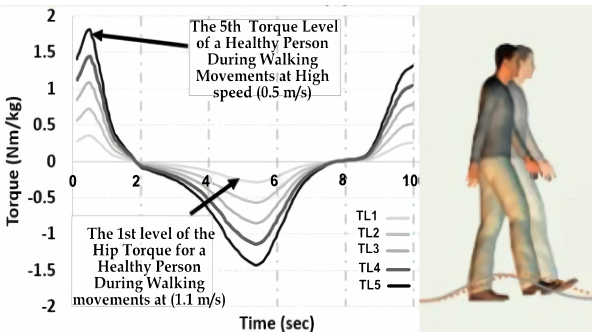
Figure 2. The hip torque during walking activity